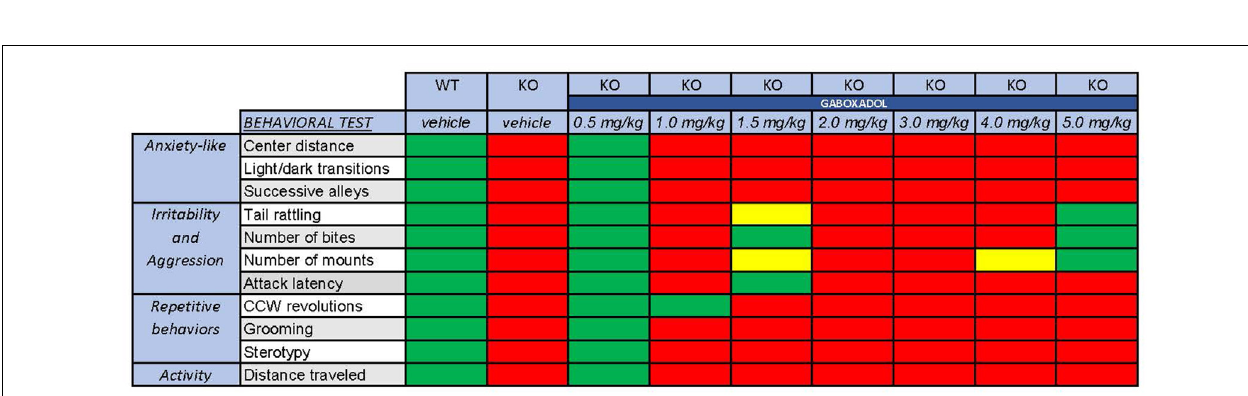
FIGURE 4 | Gaboxadol normalizes repetitive behaviors in Fmr1 KO2 mice. WT mice treated with vehicle (white bar), Fmr1 KO2 mice treated with vehicle (KO, dark gray bar), or Fmr1 KO2 mice treated with gaboxadol (KO-0.5–5.0 mg/kg, light gray bars) were subjected to four tests that measure repetitive behaviors. (A) Counter-clockwise (CCW) revolutions were measured by infrared beam breaks during a 5-min test in the Open Field. (B) After a 5-min habituation to the test cage, time spent grooming for 3 min is shown. (C) Stereotypy counts (head bobbing events) during a 3-min testing period are shown. Bars are means ± SEM, dots are raw data from individual mice. ∗∗∗∗ p < 0.0001 vs. WT-vehicle group; ns, not significant vs. WT-vehicle group; ++++ p < 0.0001 vs. Fmr1 KO2 vehicle group. N = 10 per group.